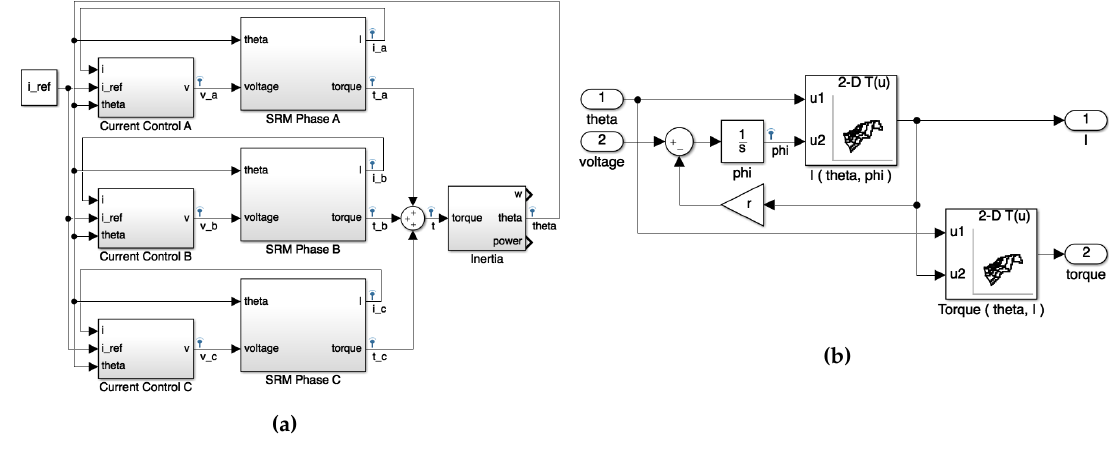
Figure 9. Simulink model of SRM. ( a ) Main model; and ( b ) sub-model of SRM Phase A.